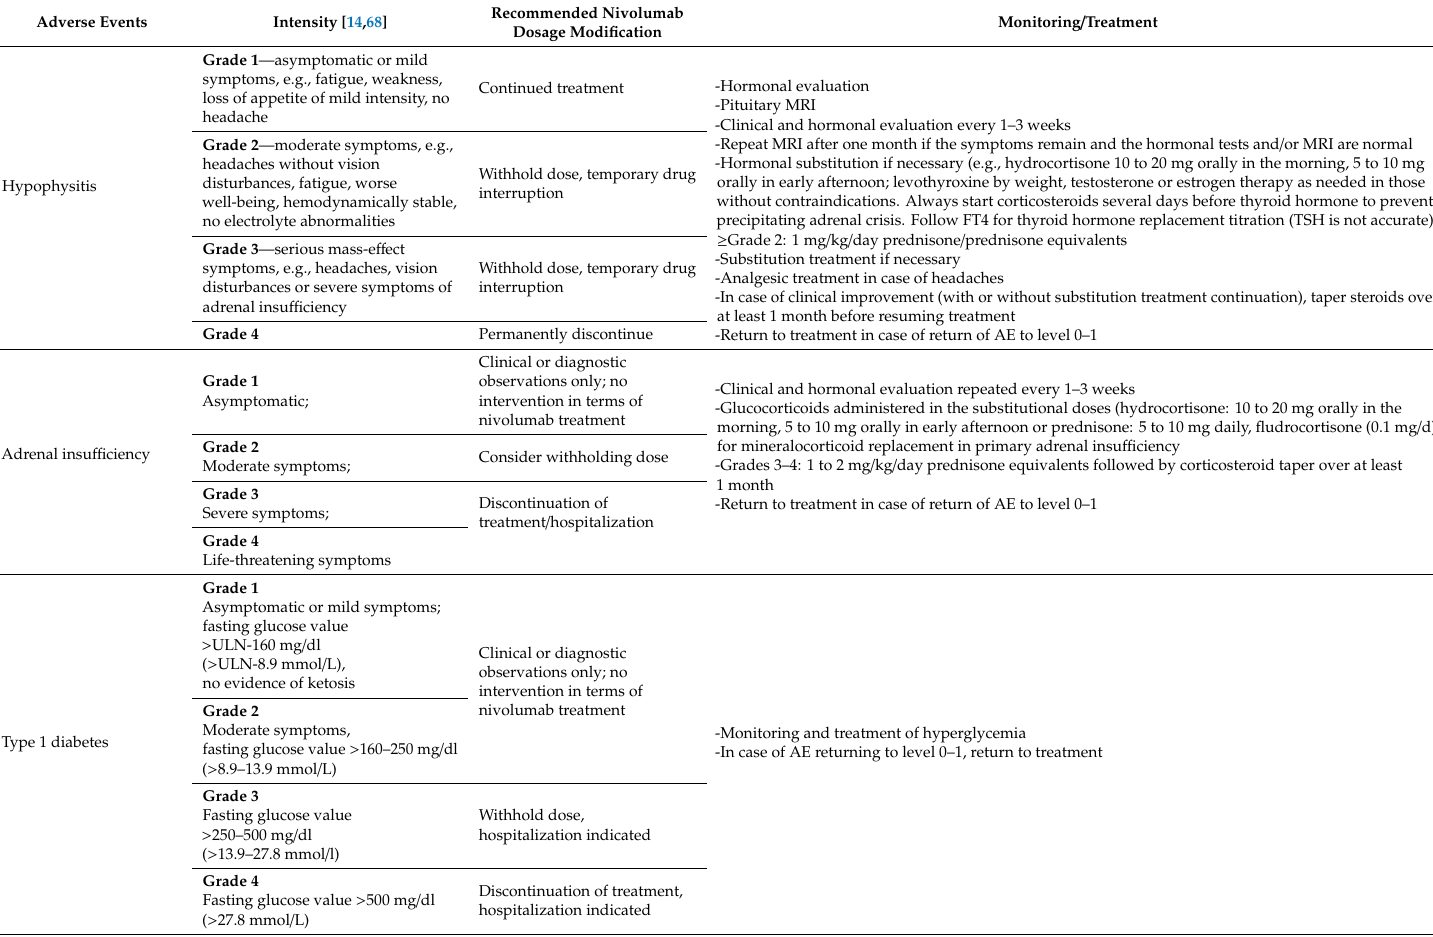
Table 2. Adapted management algorithm for endocrine adverse events during nivolumab treatment